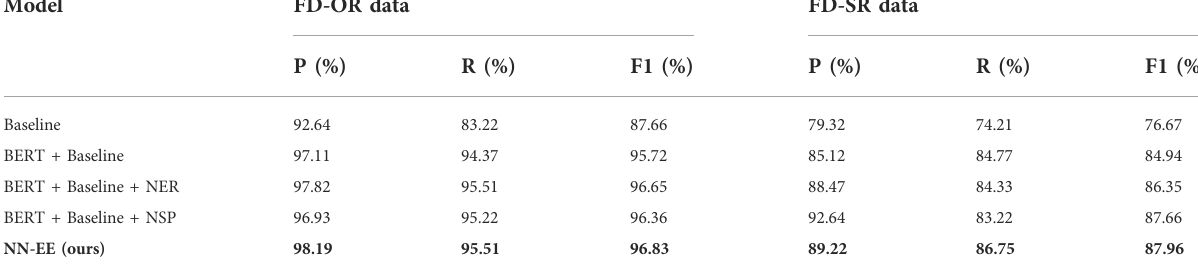
TABLE 5 Experimental results of event